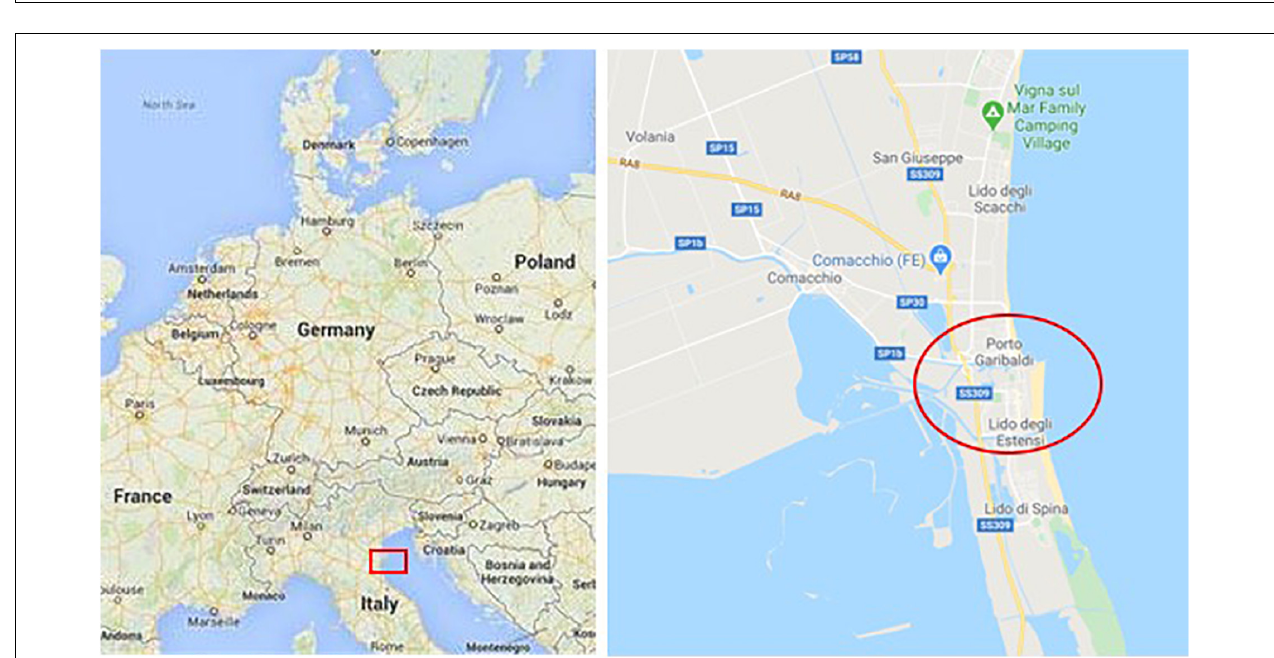
FIGURE 2 | Map of Ummanz. Source: Created by using map data © 2020 Google/INEGI.